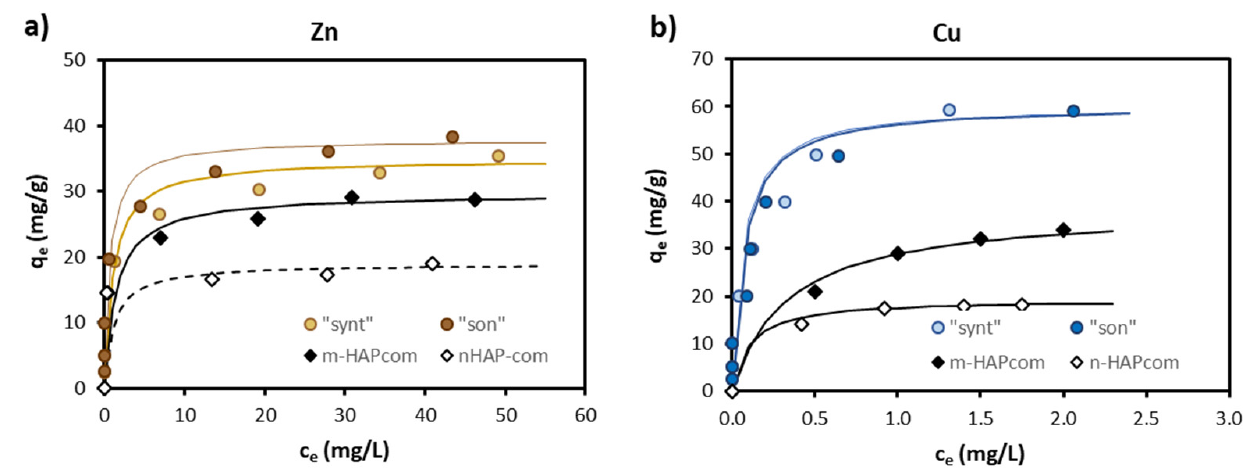
Figure 6. Sorption isotherms for Zn ( a ) and Cu ( b ) onto the sorbents evaluated in this study. Symbols represent experimental data and fitting lines are the isotherms derived from the Langmuir equations. Table 3. Summary of obtained Langmuir adsorption